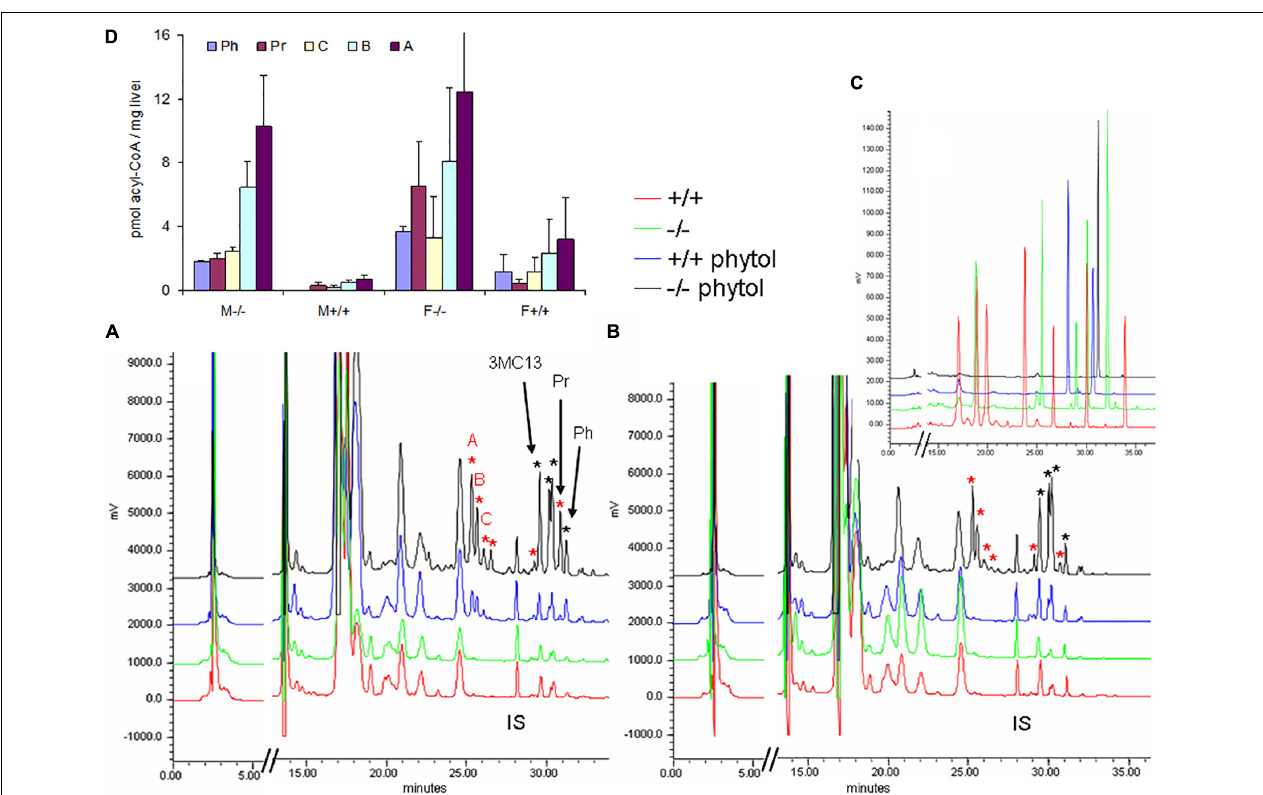
FIGURE 8 | Hepatic acyl-CoA profiles of phytol challenged PMP34 knockout mice. Panels (A,B) show representative RP-chromatograms of etheno-acyl-CoAs (and other adenine-containing compounds), prepared from liver extracts of female (A) or male (B) wild type and PMP34 deficient mice on a normal or phytol-enriched diet, spiked with internal standard (500 pmol 3-methyldodecanoyl-CoA, IS). Arrows indicate the elution, based on spiking and co-elution, of phytanoyl-CoA (Ph), pristanoyl-CoA (Pr), and 4,8,12-trimethyltridecanoyl-CoA (3MC13). New peaks appearing in the phytol-treated female +/+ animals, and further increased in all –/– mice, are marked with a red asterisk. Some phytol-derived intermediates, marked with a black asterisk, elute close to straight acyl-CoAs, impeding baseline separation. The elution of different standards as etheno-derivatives, is shown in panel C (taken from Mezzar et al., 2017): mix 1 (red) contains CoA, acetyl-, propionyl-, hexanoyl-, decanoyl-, palmitoyl- and lignoceroyl-CoA; mix 2 (green) acetyl-, octanoyl-, tetradecanoyl-, palmitoyl- and eicosanoyl-CoA; mix 3 (blue), IS and pristanoyl-CoA; mix 4 (black) phytanoyl-CoA. Panel (D) shows the quantification of known and some unknown, labeled as A–C in panel (A) , phytol-derived acyl-CoAs (values based on 2 separate mice per gender and per genotype; mean ±